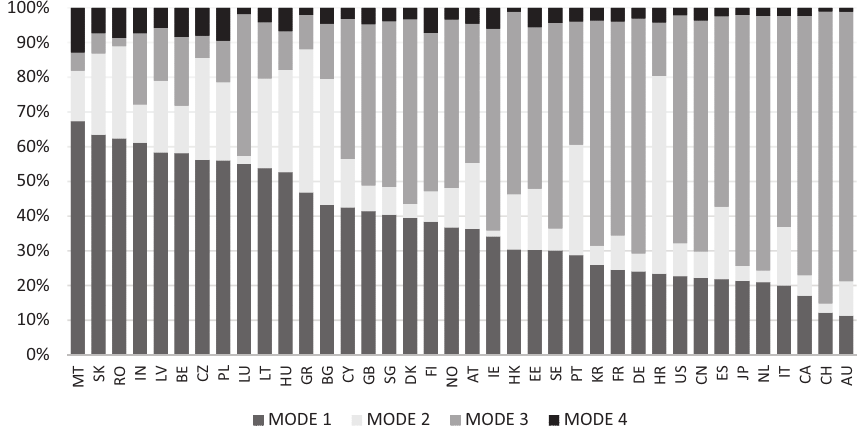
Figure 1. Service exports in four modes, %, 2017 (source: WTO mode of supply dataset, authors’